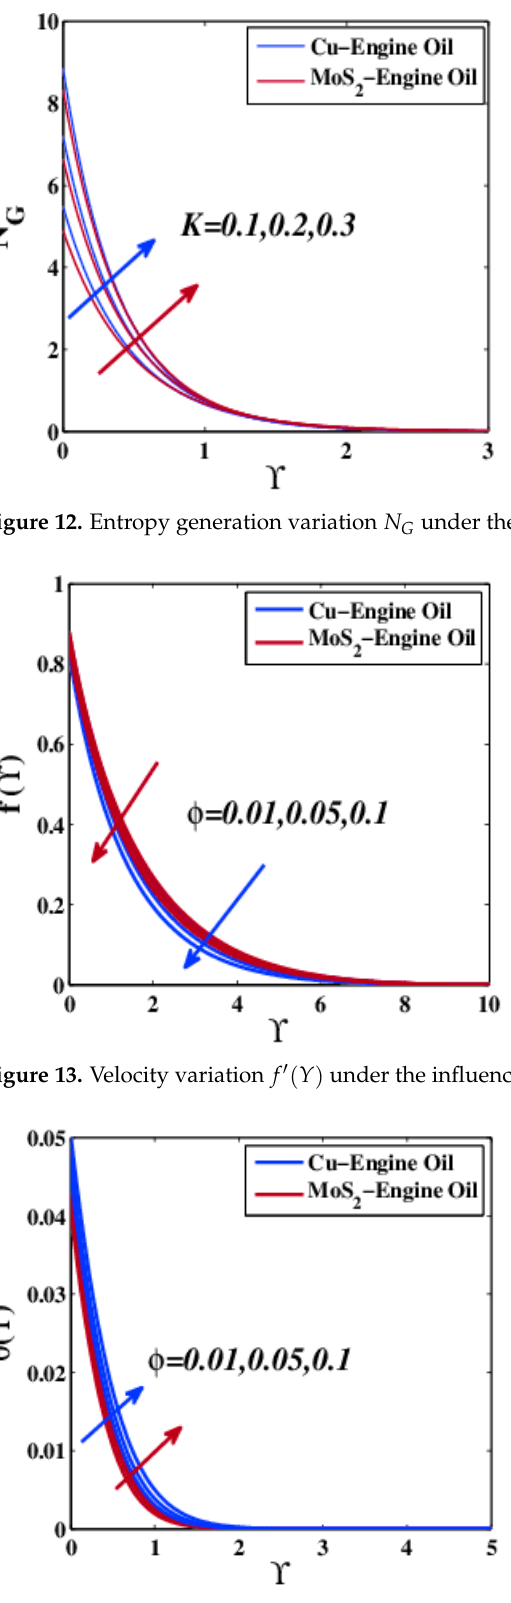
Figure 14. Temperature variation θ ( Y ) under the influence of φ .